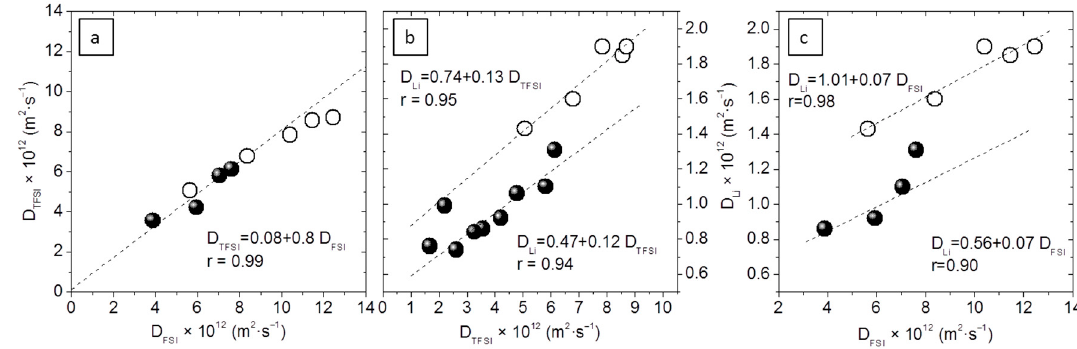
Figure 7. Relationship between ( a ) D TFSI and D FSI , ( b ) D Li and D TFSI , and ( c ) D Li and D FSI . Open circles represent the electrolytes of EMIFSI series.